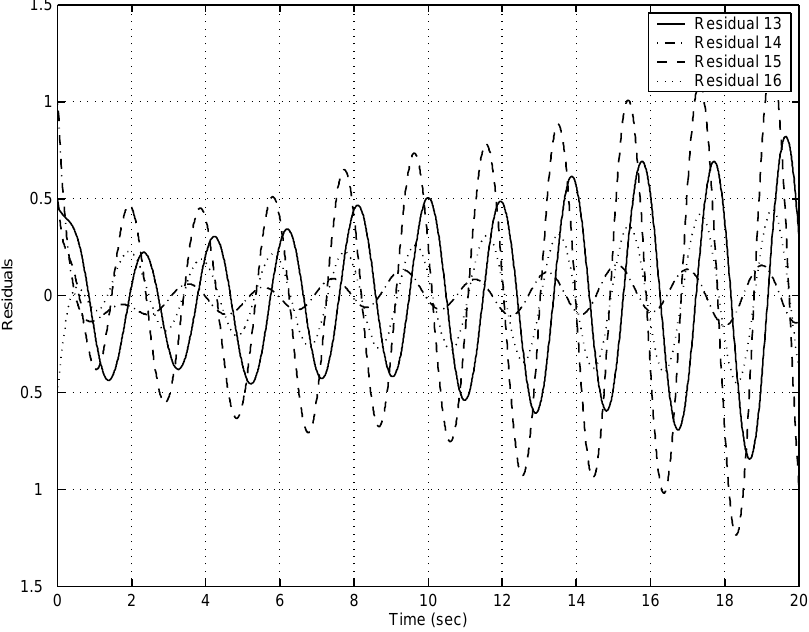
Fig. 17. Residuals 13-16 for 8 mode simulation with δ 1 = 0 . 01 .